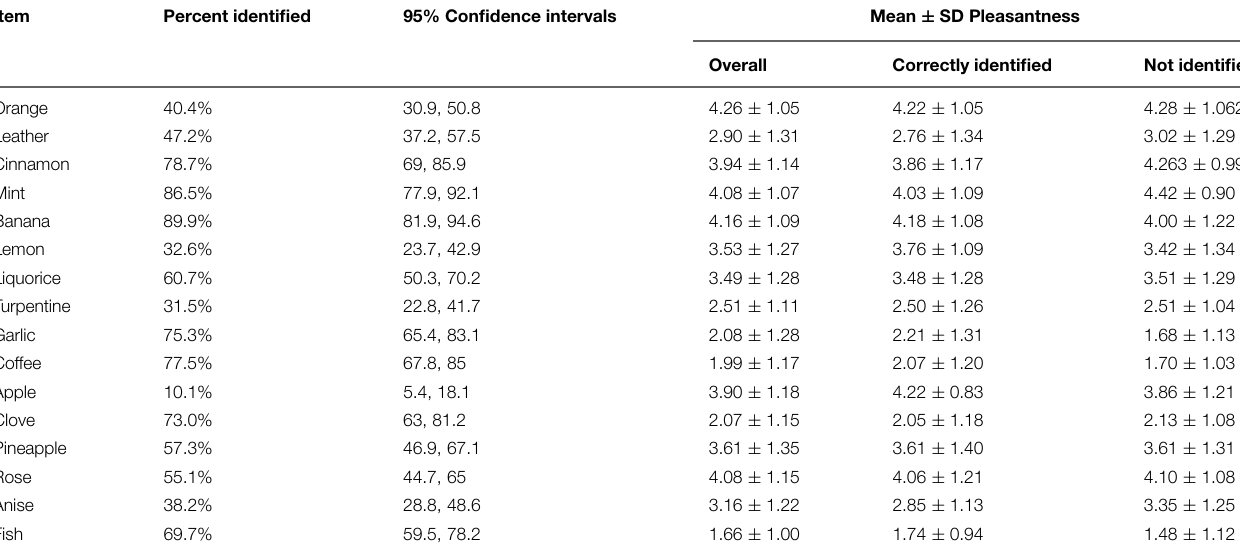
TABLE 1 | Percentages of correct identifications and mean pleasantness for individual items of the Sniffin‘ Sticks identification test ( N =